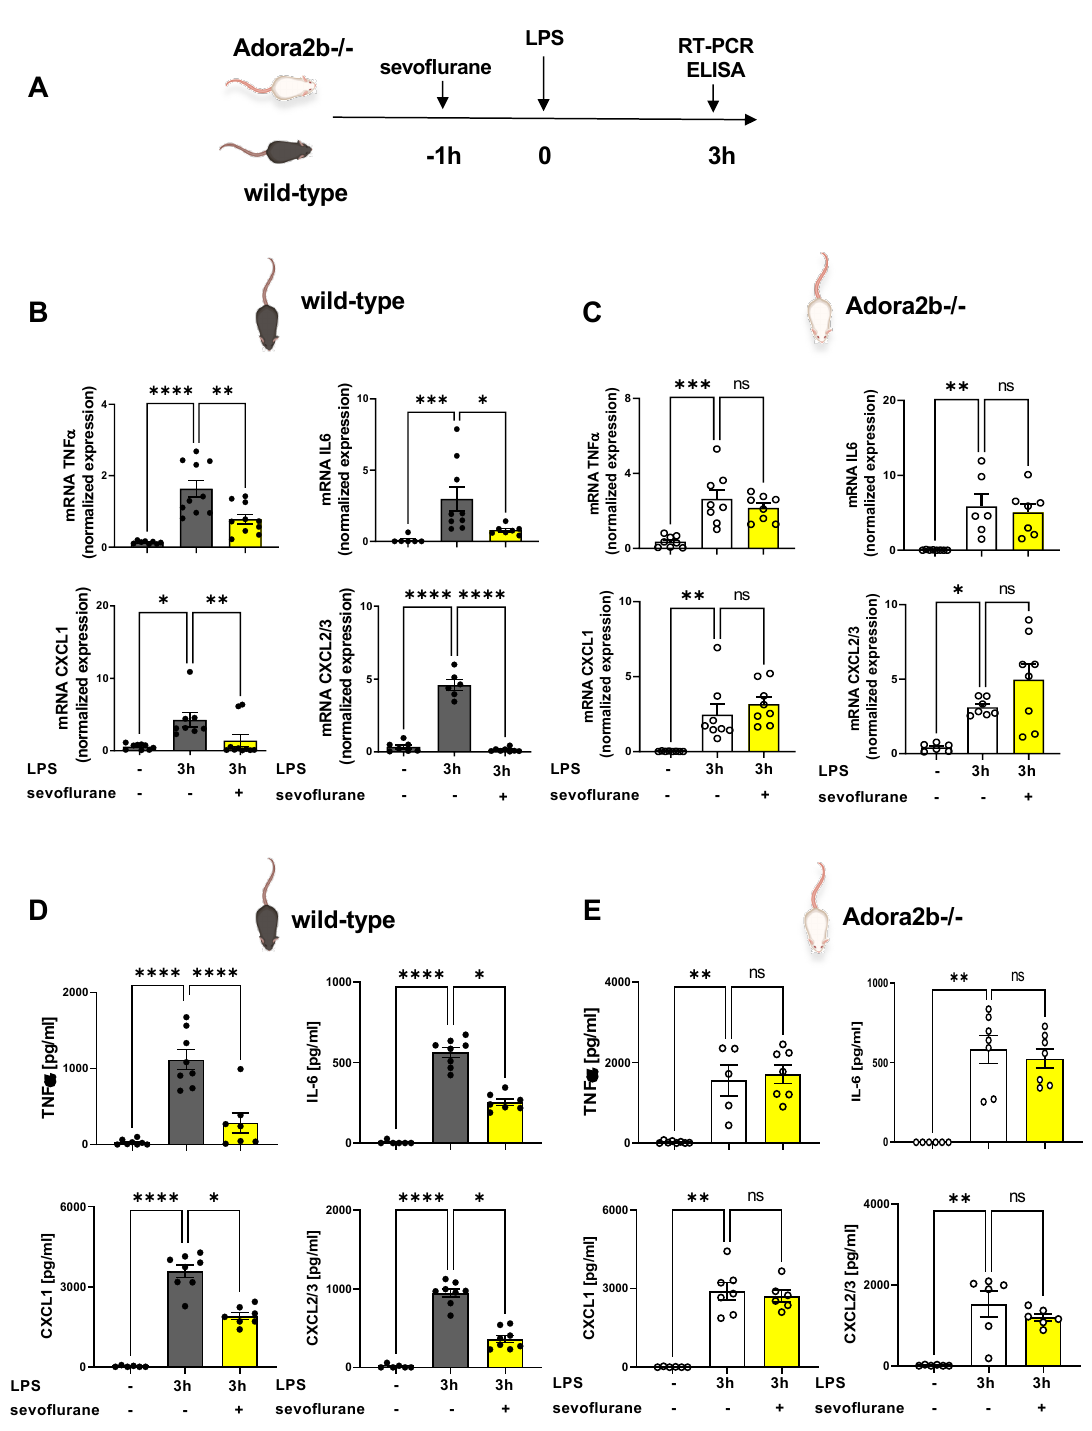
Figure 5. Influence of sevoflurane on the release of cytokines and chemokines in the bronchoalveolar lavage. ( A ) Wild-type and adenosine A2B receptor − / − (Adora2b − / − ) mice were treated with sevoflurane. Three hours after LPS exposure, the gene expression ( n = 6–10) and the release of inflam- matory mediators such as tumor necrosis factor (TNF) α , interleukin (IL) 6, CXCL1, and CXCL2/3 were determined by real-time polymerase chain reaction and enzyme-linked immunosorbent assay from the pulmonary tissue and bronchoalveolar lavage of ( B , D ) wild-type and ( C , E ) Adora2b − / − animals ( n = 6–8). Statistical analyses were performed by one-way ANOVA + Bonferroni correction or Kruskal-Wallis test. Data are presented as mean ± SEM; ns = not significant * p < 0.05; ** p < 0.01; *** p < 0.001; **** p <